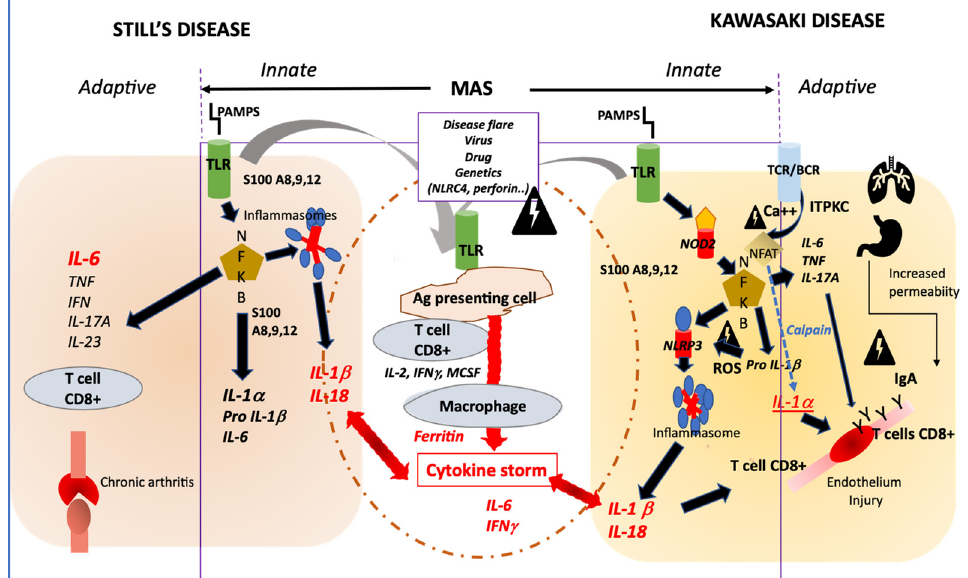
Figure 1. Profiles of immune activation are similar in Still’s disease and Kawasaki disease. Innate immune system : In both diseases danger signals coming from outside (PAMPS) sensed by TLR or from inside (DAMPS) coming from activated macrophages (such as S100 proteins) may activate both the NFKB and the NLRP3 inflammasome pathways that drives the secretion of IL-1 β and IL-18. In both diseases, additional triggering event such as disease flare, infection, in the context of genetic modifiers, may induce an amplification cascade of inflammation resulting in MAS. Adaptive immune system : In KD, the adaptive immune system may be activated primarily through antigen recognition by the BCR and TCR, and genetic variation in ITPKC may impair the regulation of calcium fluxes and then remove the inhibition of NFAT, which induces the secretion of IL-1 α , a potent inducer of endothelial cells activation. In both Still’s disease and KD, NFKB activation induces an increased secretion of IL-6 and IL-17A, which participates in one case in bone erosion and inflammation and in the other case in endothelial inflammation and damage. Involvement of IgA from increased intestinal permeability and/or respiratory tract may participate to endothelial injury in KD. PAMPS: pathogen associated molecular patterns; DAMPS; danger associated molecular pattern; TLR; Toll-like receptor; NFKB; nuclear factor; NLRP3: NOD-like receptor family, pyrin domain containing 3; MAS: macrophage activation syndrome; BCR: B cells receptor; TCR: T cells receptor; ITPKC: inositol-trisphosphate 3-kinase; NFAT: Nuclear factor of activated T-cells; ROS: reactive oxygen species; NOD2: nucleotide-binding oligomerization domain